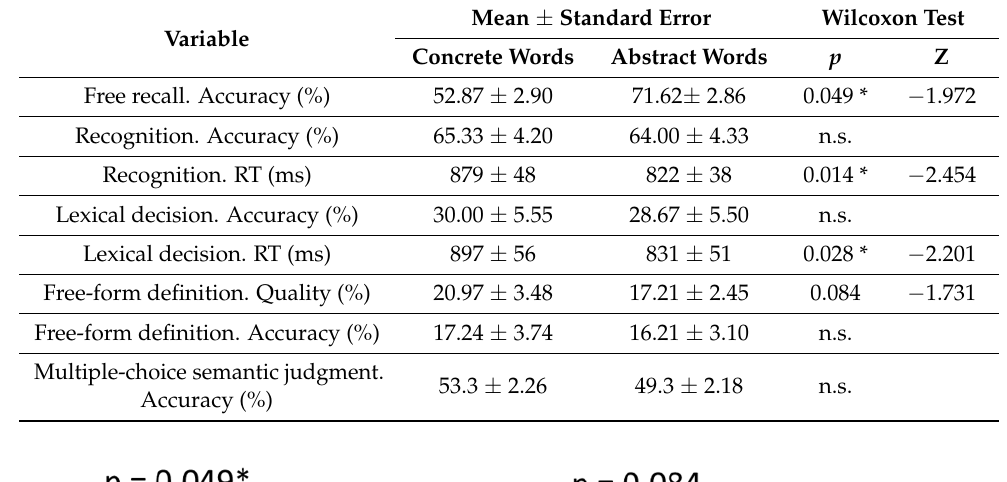
Table 2. Descriptive statistics and pairwise comparisons for behavioural data (* denotes significant differences at 0.05 level).